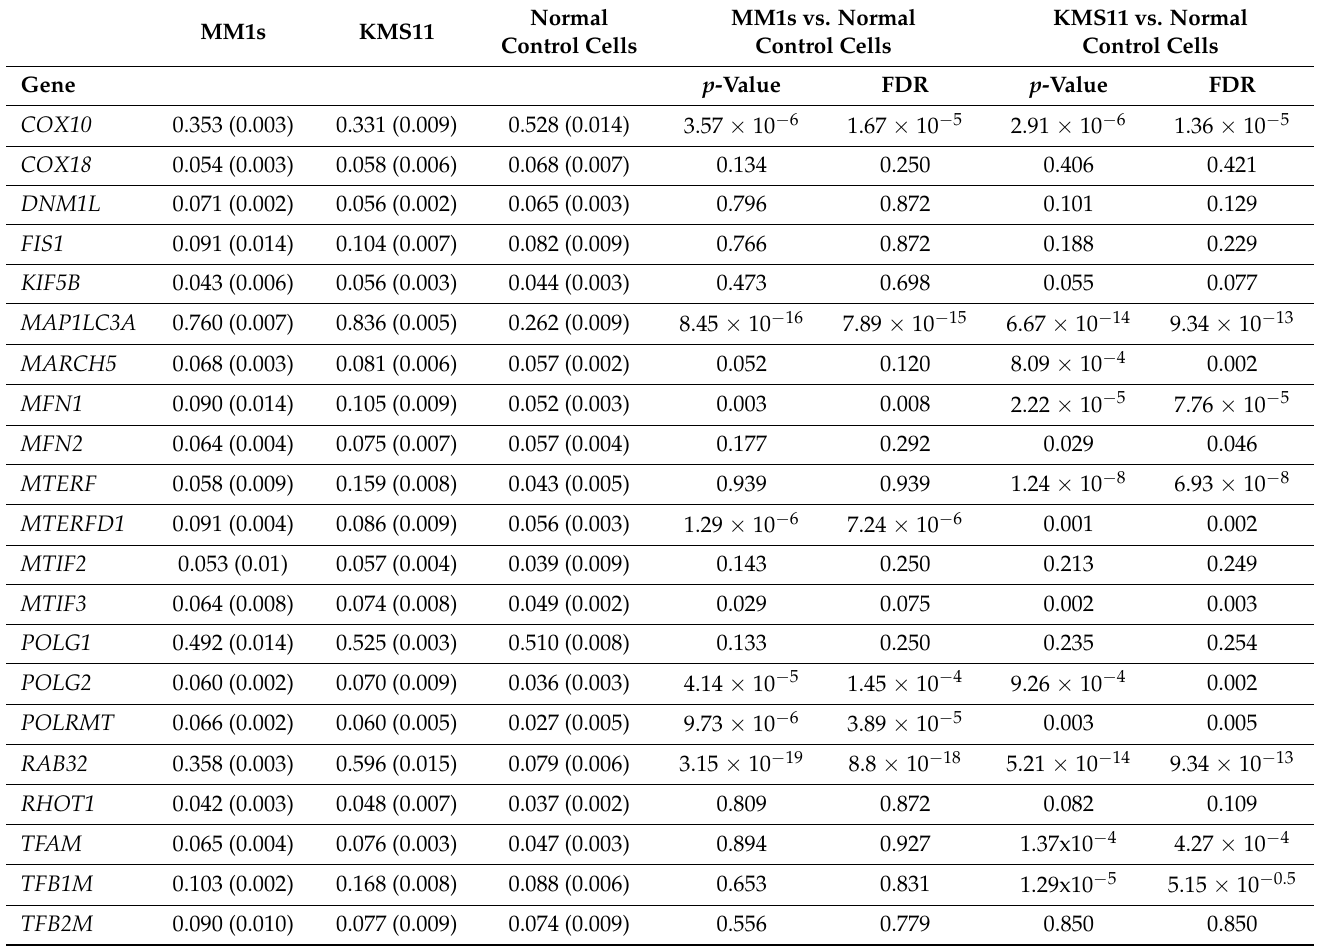
Table 1. Mean of DNA methylation values (and standard deviation) of CpG sites located within the analysed genes in HMCLs (MM1s, KMS11) and normal control cells (PBMCs). HMCLs, human myeloma cell lines; FDR: False Discovery